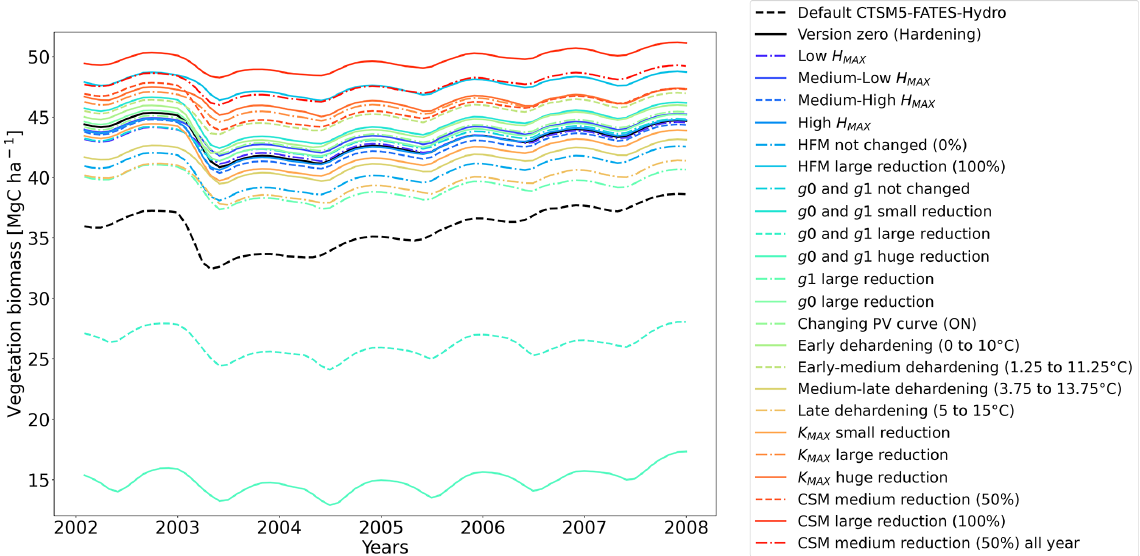
Figure 12. Ensemble of living biomass simulations for needleleaf evergreen trees at the site of Farstanäs during the period